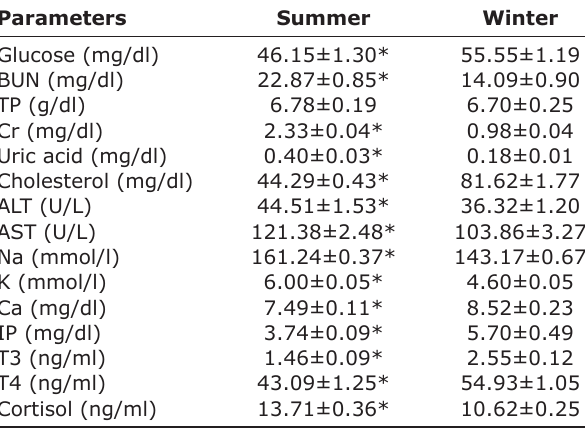
Table-3: Biochemical parameters (mean±SE) during summer and winter season.